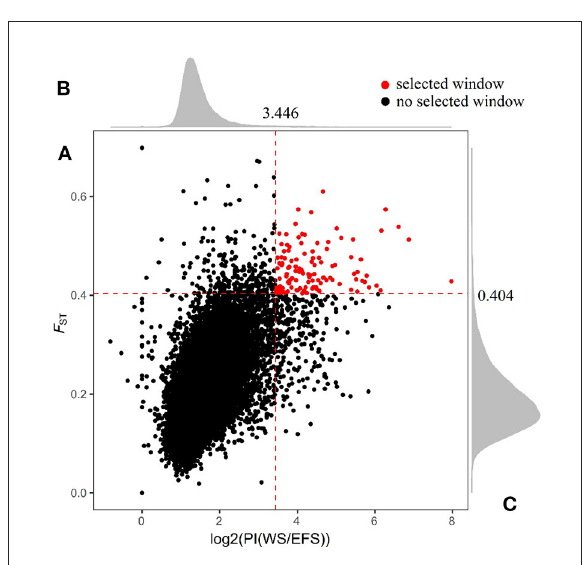
FIGURE4 Shared genomic region of F ST and θ π ratio. (A) Window shared between F ST and top 1% of PI. (B) Density distribution of PI in all Windows. (C) Density distribution of F ST in all Windows. The red dashed line in the figure is the top 1% threshold